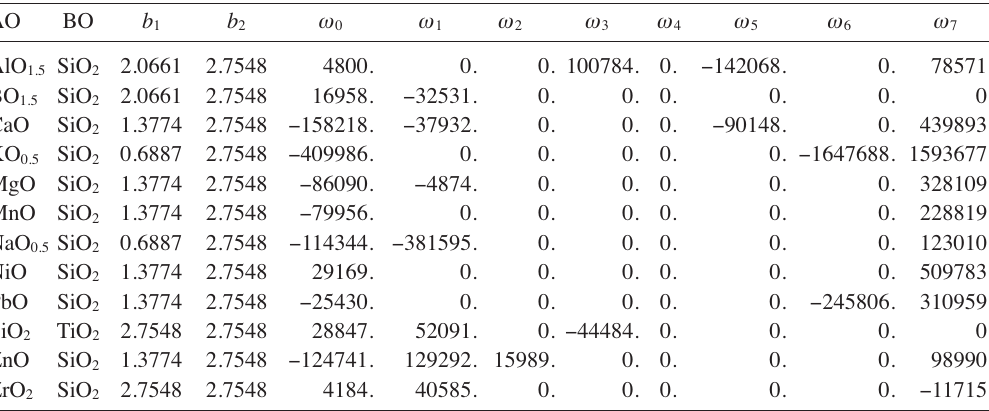
Table III. Chemical interaction parameters of modified- quasi -chemical model for binary silicate melts (after Pelton et al. , 1995). AO